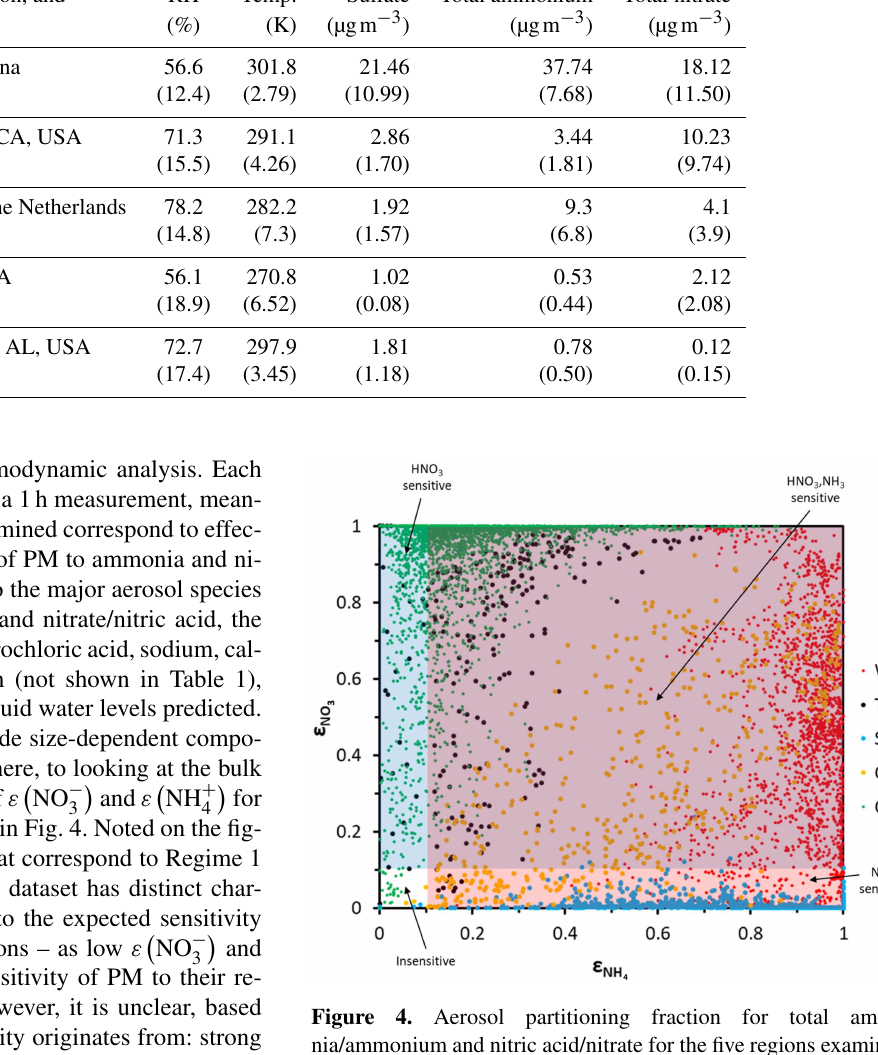
Table 1. Characteristics of the datasets used for determining the sensitivity to NH 3 and HNO 3 emissions. Shown is the average relative humidity (RH), temperature (K), and the concentration of major aerosol precursors (µgm − 3 ), while in the respective standard deviation for each parameter is shown in parenthesis. Access to the data is described in the “Code and data availability” section. Dataset ID, location, and